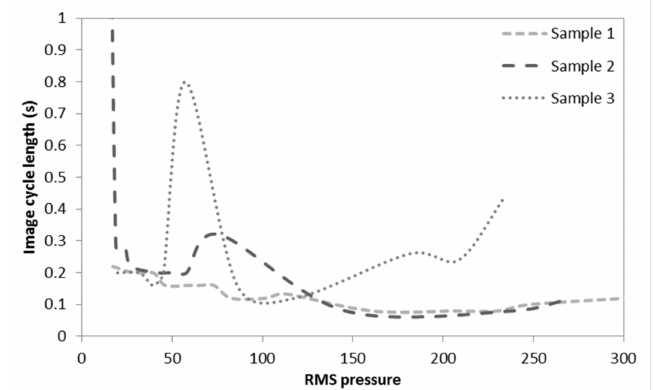
Figure 13. Duration of each cycle of a repeated oscillatory pattern across the range of applied pressures for the installed reference